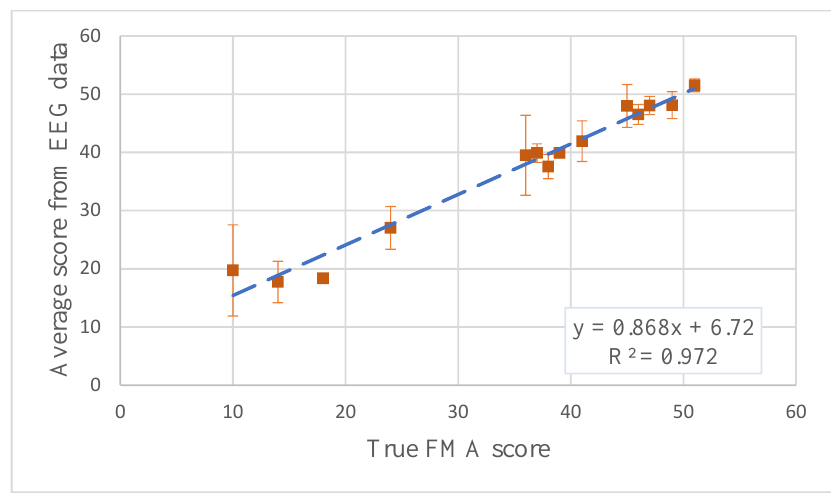
Figure 4. The model test result for ResNet method ( n = 14); the healthy participants’ results were not included in the correlation analysis as their data were clustered around the (66, 66) area, which would affect the correlation analysis results. The assessment scores were produced with one trial of EEG data and averaged across all trials from one participant.